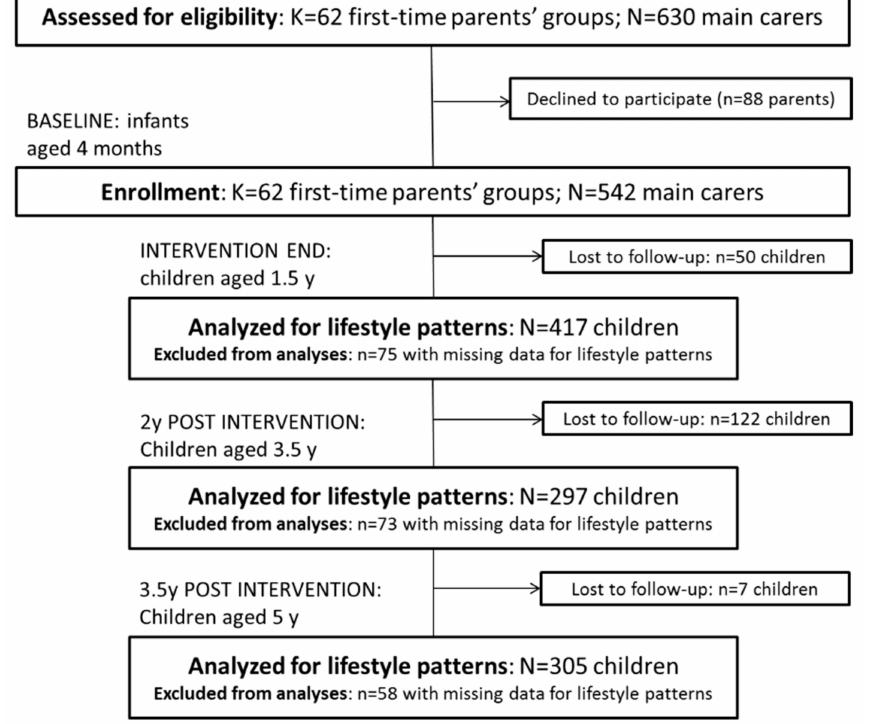
Figure 1. Flow of participants through the Melbourne InFANT